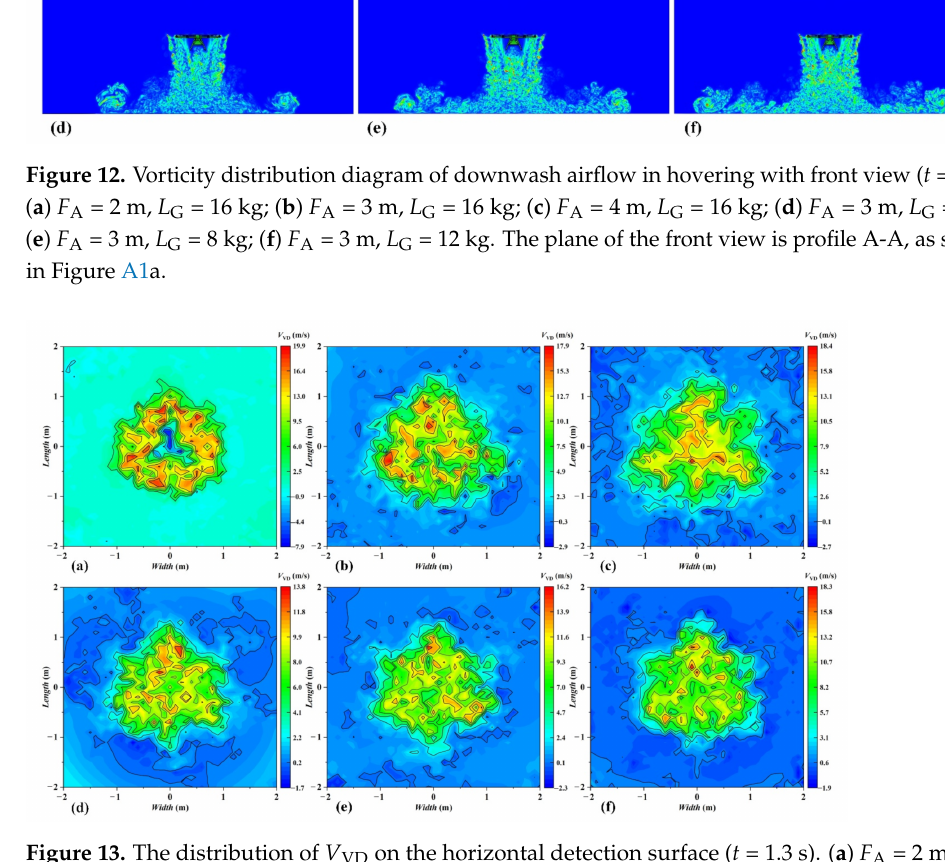
Figure 13. The distribution of V VD on the horizontal detection surface ( t = 1.3 s). ( a ) F A = 2 m, L G = 16 kg; ( b ) F A = 3 m, L G = 16 kg; ( c ) F A = 4 m, L G = 16 kg; ( d ) F A = 3 m, L G = 4 kg; ( e ) F A = 3 m, L G = 8 kg; ( f ) F A = 3 m, L G = 12 kg. The distance between the detection surface and the ground was 1 m and the negative value of V VD indicates that the velocity direction is vertical